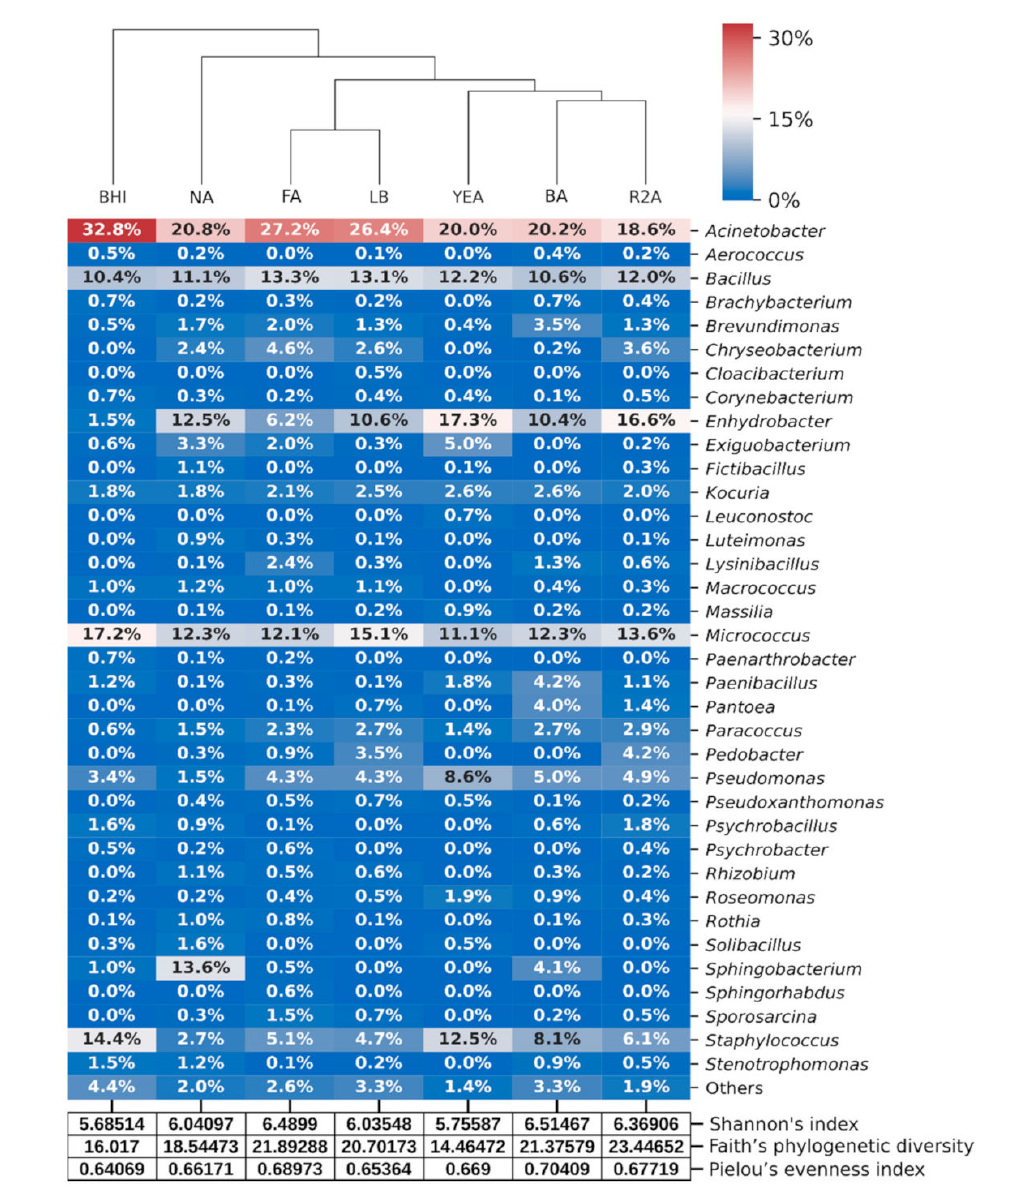
Figure 3. Cultivable bacteria taxonomy and their relative abundances. Heatmap with a dendrogram, depicting genera detected on the investigated media, and the following alpha-diversity indexes for each medium: Shannon’s index, Faith’s phylogenetic diversity, and Pielou’s evenness index. Only the genera that constituted at least 0.5%, abundance-wise, of all genera on at least one medium are shown on the heatmap. Genera accounting for less than 0.5% across all samples were assigned to the